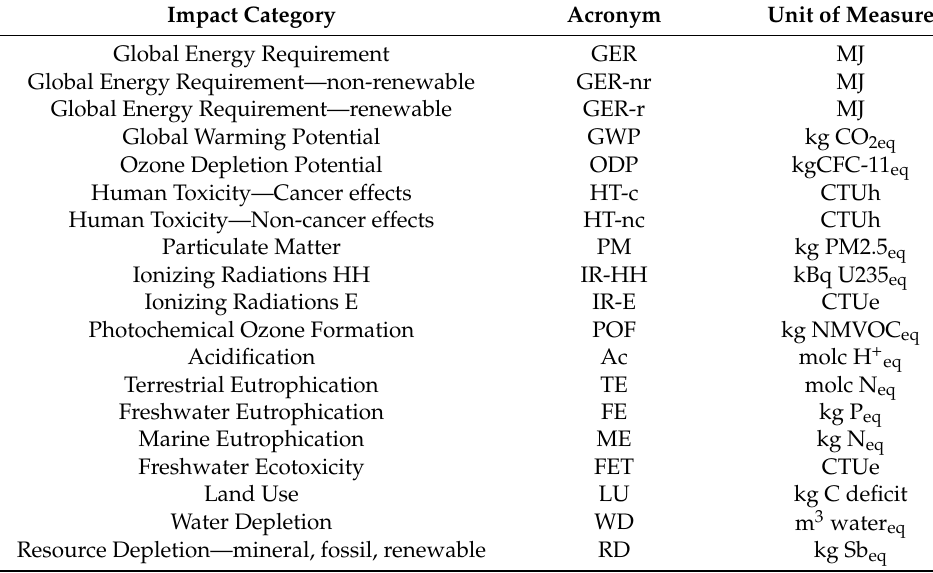
Table 1. Energy and environmental